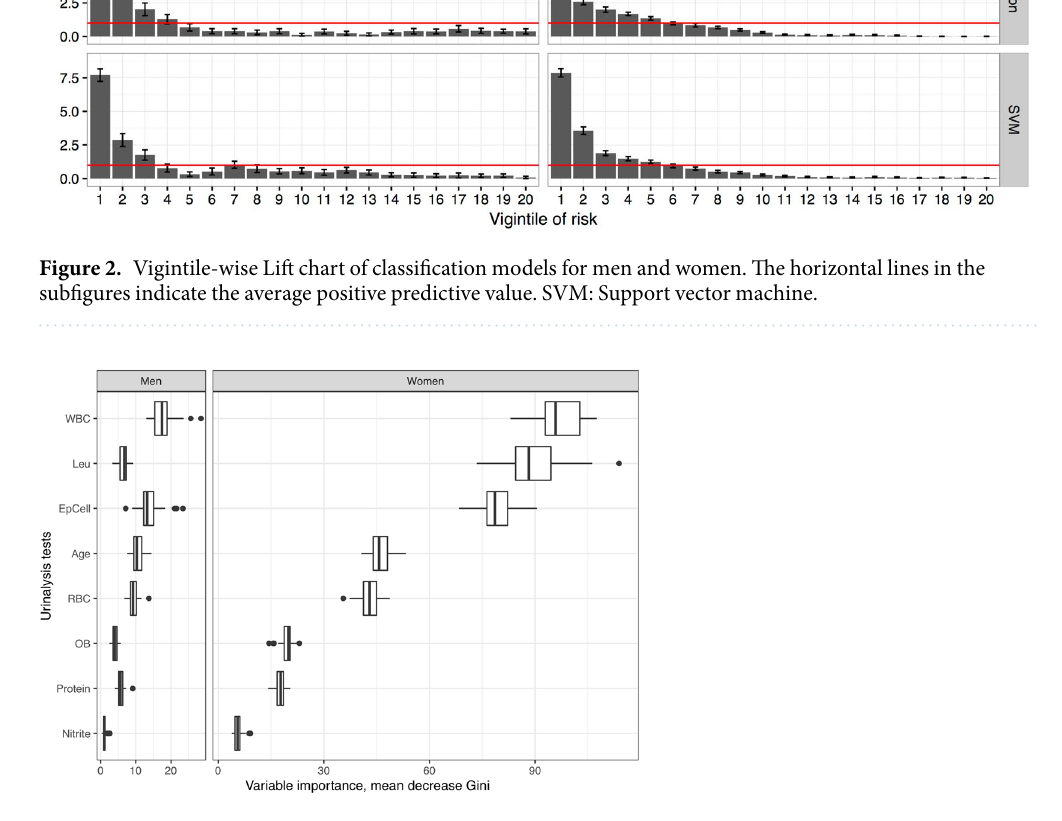
Figure 3. Variable importance of the optimal random forest model, defined by the mean decrease in